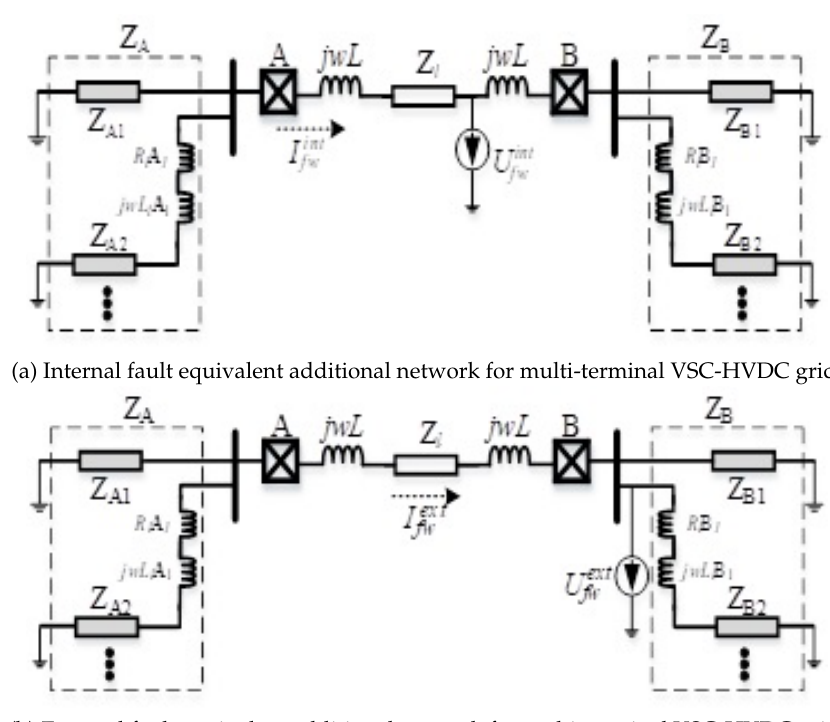
Fig. 5. Fault equivalent network of the multi-terminal VSC-HVDC